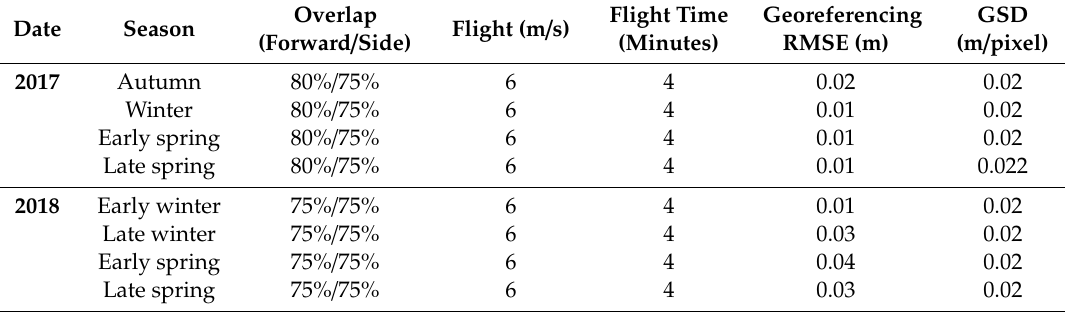
Figure 2. Aerial and ground-based platforms for high-throughput phenotyping ( a ) UASs platform and sensors; ( b ) PhenoRover system and sensors at the experimental site. Table 2. Details of UAS data acquisition and processing